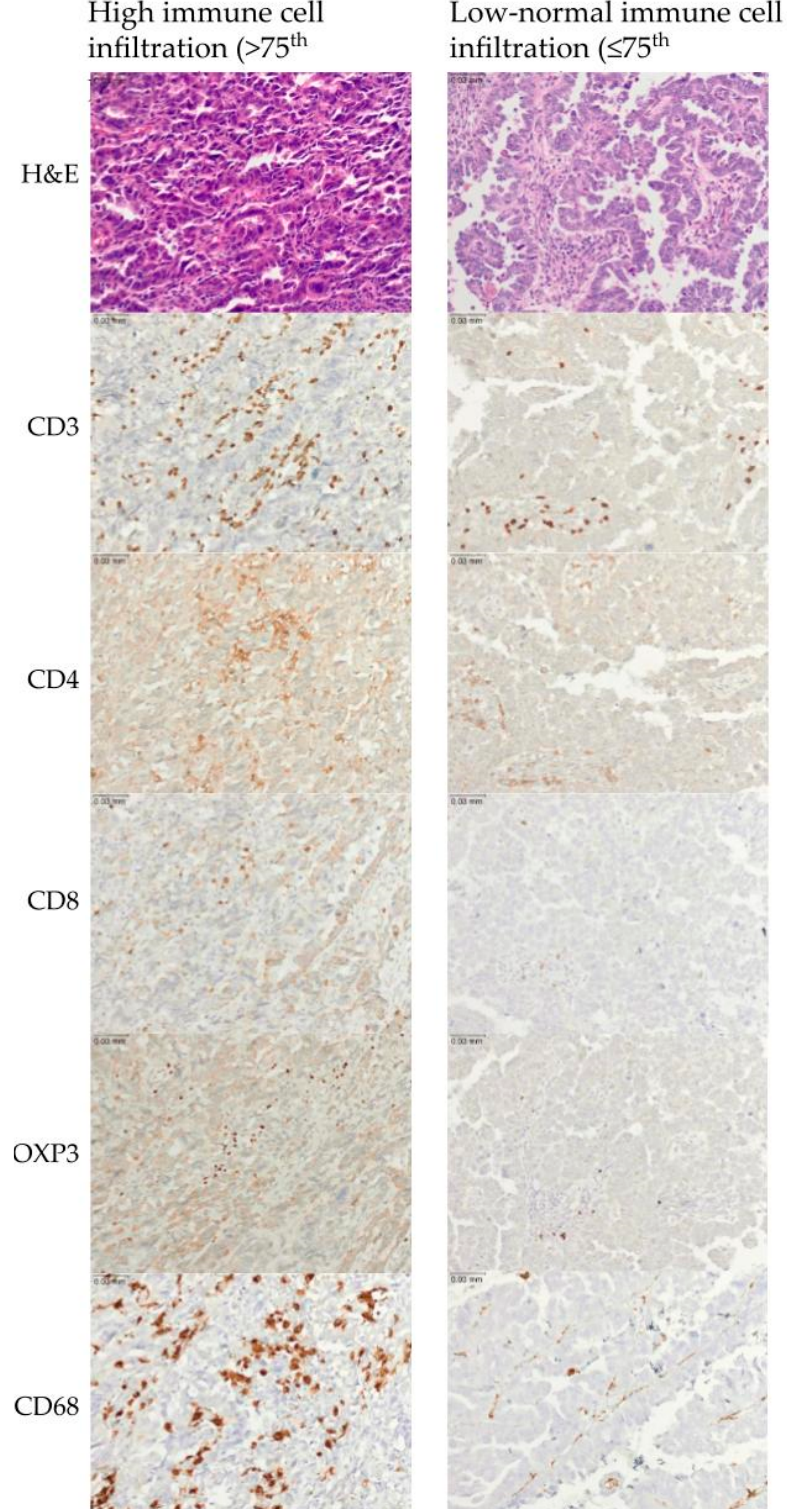
Figure 2. Representative examples of immune cell infiltration for CD3, CD4, CD3, FOXP3, and CD68. The upper row represents high immune cell infiltration (>75th percentile). The lower row represents low–normal immune cell infiltration ( ≤ 75th percentile). Scale bar is 0.03 mm.